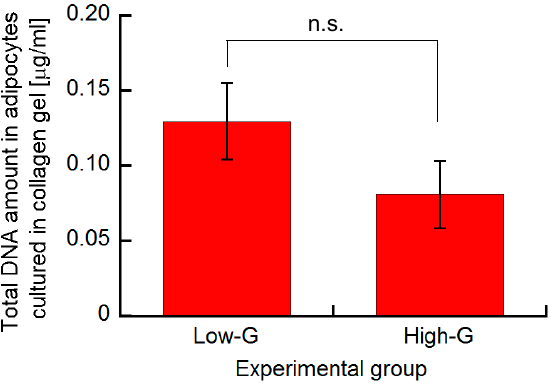
Figure 4. Total DNA amount in adipocytes cultured in collagen gel. Data are presented as mean ± S.D., n = 4.